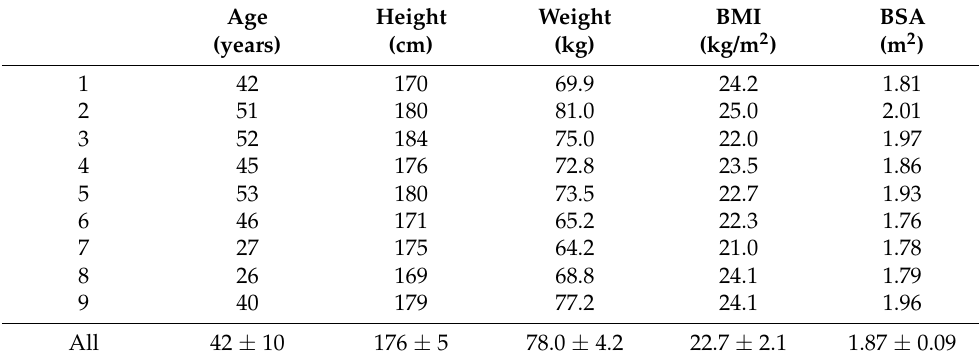
Table 1. Characteristics of the